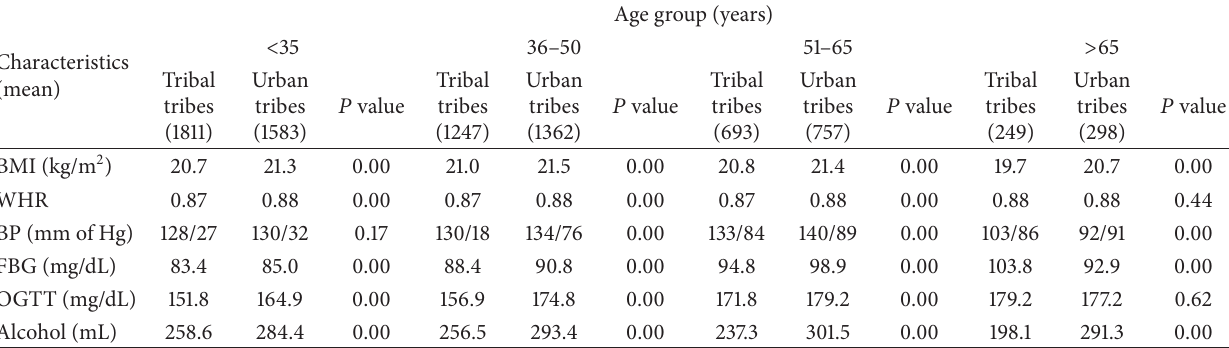
Table 4: Age group distribution of mean levels of anthropometry, blood glucose, and alcohol consumption among tribes of urban and tribal areas, Himachal Pradesh, 2011-2012.